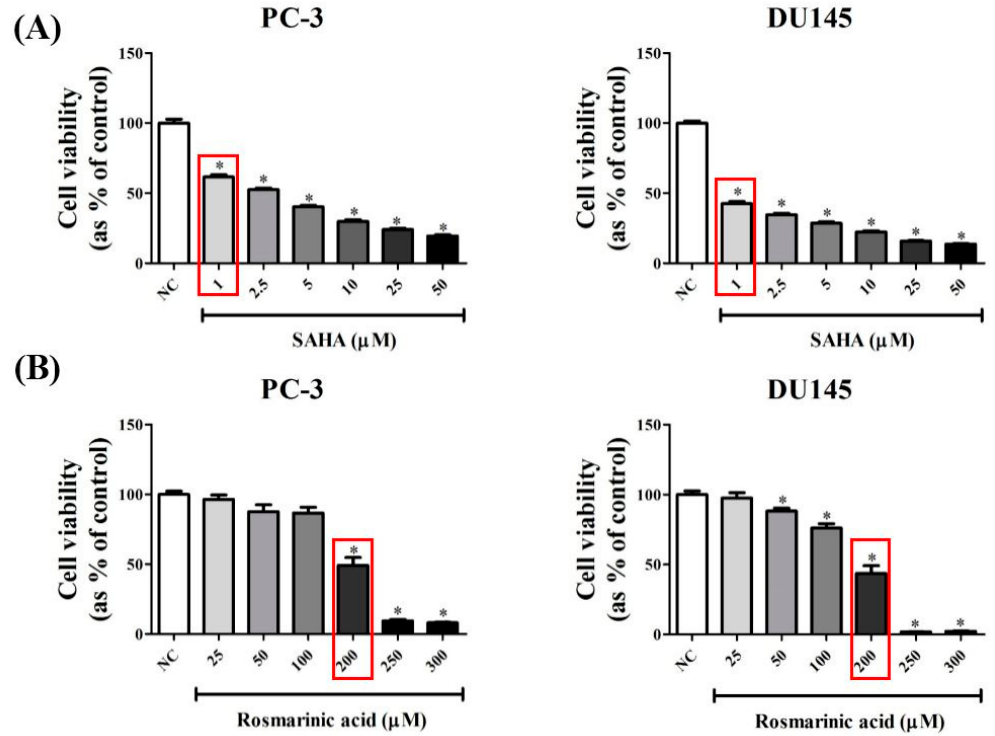
Figure 1. Effects of suberoylanilide hydroxamic acid (SAHA) and Rosmarinic acid (RA) on cell viability in PC-3 and DU145 cell lines. After PC-3 and DU145, cell lines were seeded at 1 × 10 4 cells per well in 96-well plates and treated with media containing negative control (NC; DMSO), SAHA (1, 2.5, 5, 10, 25, 50 µ M) and RA (25, 50, 100, 200, 250, 300 µ M), cell viability of each cell line was evaluated. The data showed ( A ) the effect of SAHA and ( B ) the effect of RA on cell viability of both cell lines. The results are expressed as means ± standard deviation (SD). * p < 0.05: a significant difference versus control.